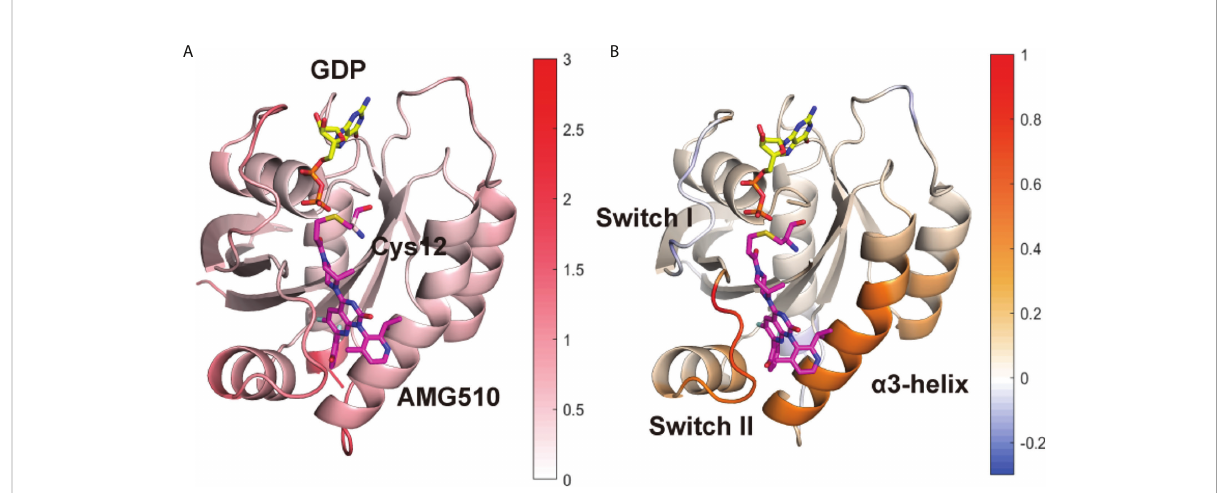
FIGURE 1 Conformational dynamics of KRAS protein. (A) The averaged RMSF values of each residue are plotted on the 3D structures of the KRAS protein in the G12C system. (B) The substation of RMSF values of the G12C/Y96D system from its counterpart in the G12C system. Positive regions (red) stand for higher RMSF values, whereas negative regions (blue) represent lower RMSF